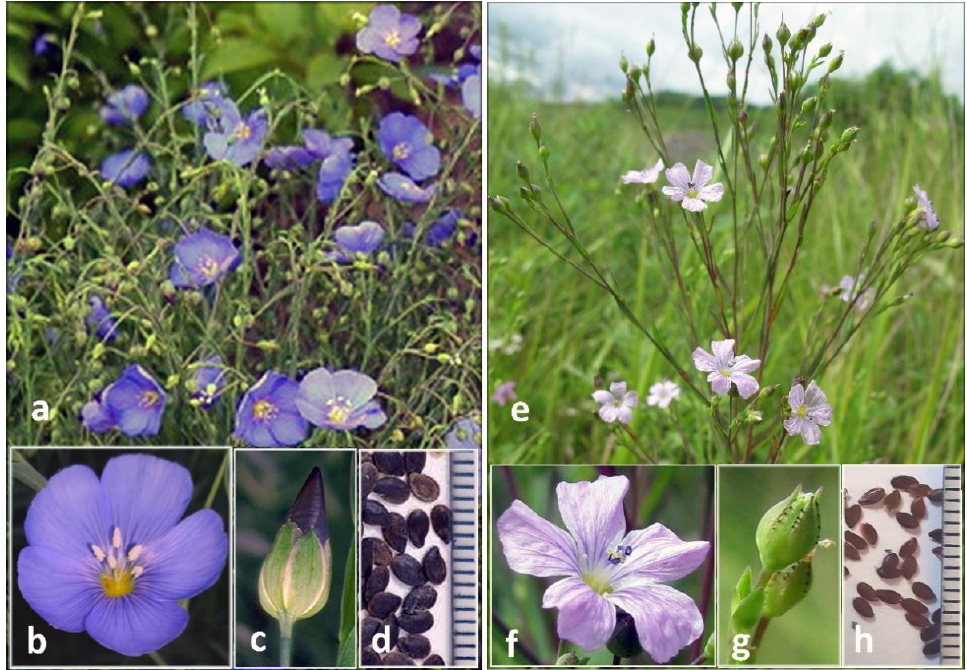
Figure 1. Photo of plants of the LIN 1655 accession ( a – d ) and L. stelleroides specimen from the Far East of Russia ( e – h ). a , e — general view of plants; b , f — flower morphology; c , g — calyx morphology; d , h — seeds, scale 1 mm. Photo of L. stelleroides in its natural habitat near the Kraskino village kindly provided by Dr. Z.V. Kozhevnikova.